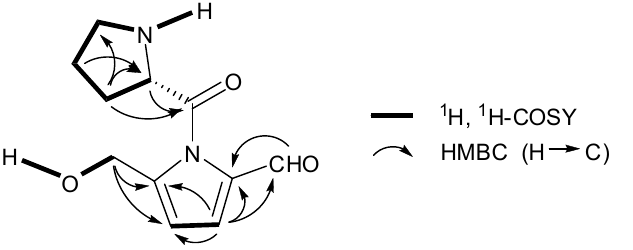
Figure 3. Key 1 H, 1 H-COSY and HMBC correlations of aconicaramide ( 5 ).